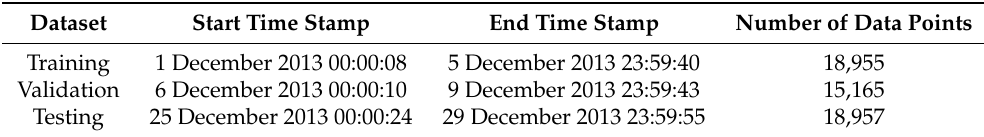
Table 1. Dataset